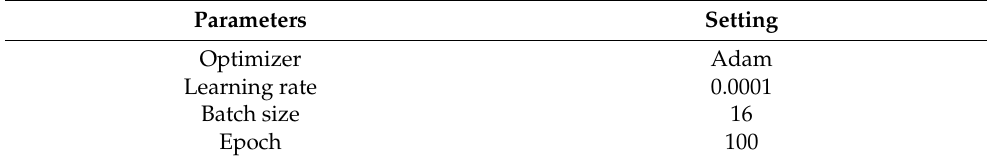
Table 5. Parameters of the training process.